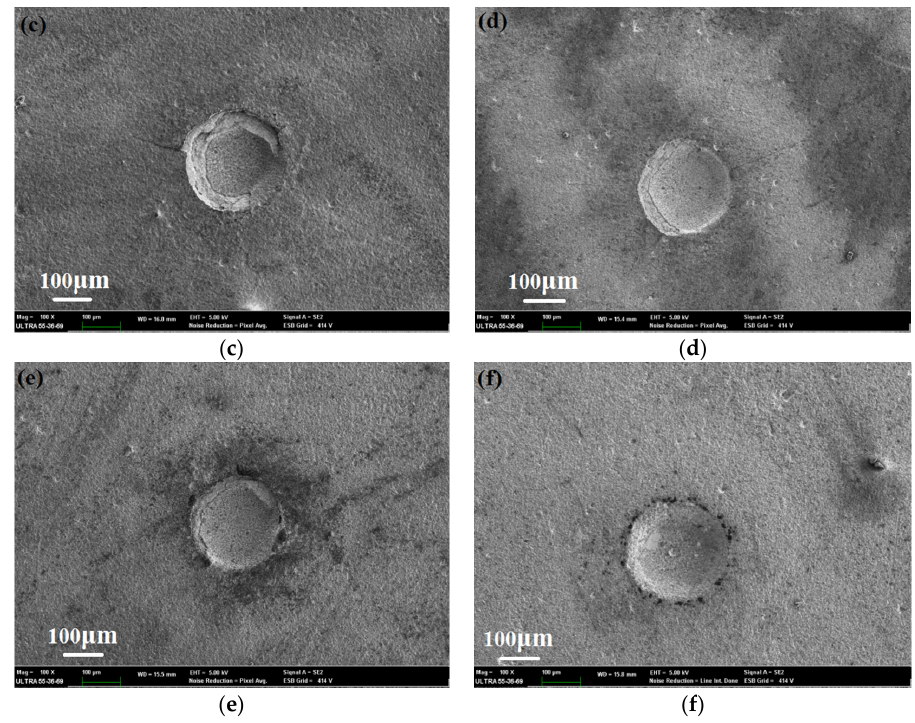
Figure 4. SEM morphology of the Rockwell indentation on Samples A to F with various silicon concentrations: ( a ) 0 atom %; ( b ) 0.11 atom %; ( c ) 0.52 atom %; ( d ) 0.98 atom %; ( e ) 1.41 atom %; ( f ) 1.81 atom %.